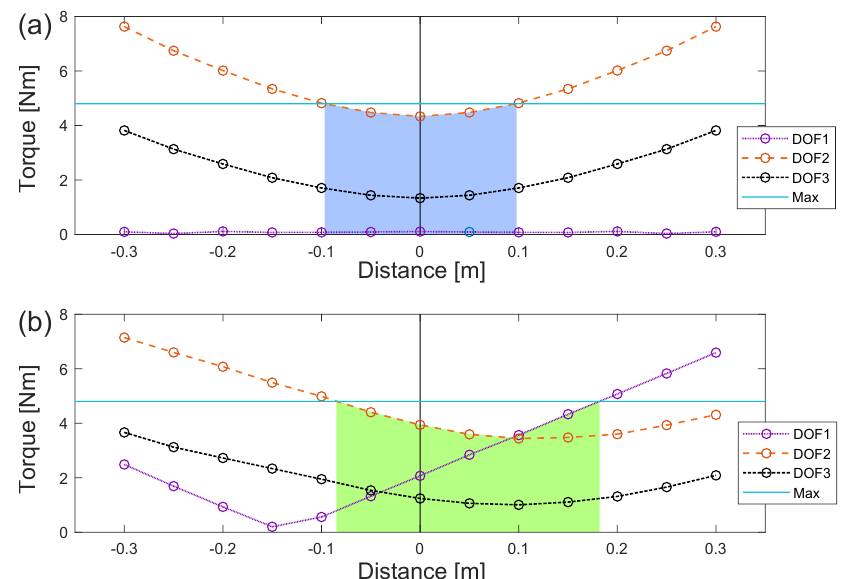
Figure 10. The motor output torques during gait for both the ( a ) template, and ( b ) anchor leg morphology. The torques are measured in 0.05 m intervals along the stepping line. The motors maximum torque capacity of 4.8 Nm is indicated with the “Max” line and a pink line in Figure 9.